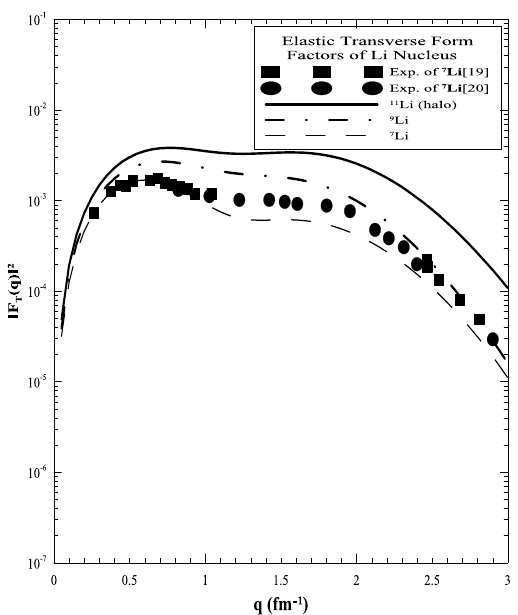
Fig. 6: Comparison between the total form factors of 11 Li (halo) (solid curve), 9 Li (dot- dashed curve) and 7 Li (dashed curve) with the experimental data of 7 Li